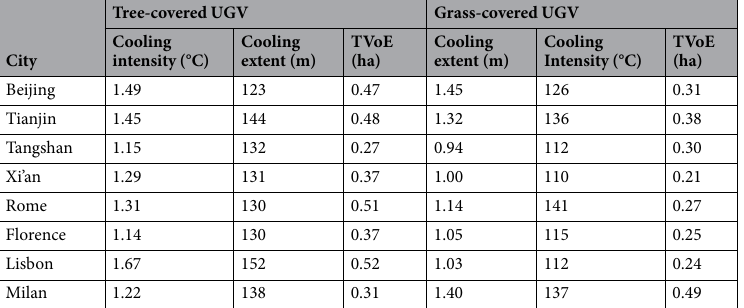
Table 3. Adjusted results of the cooling intensity, extent, and TVoE for the Tree-covered UGV and Grass- covered